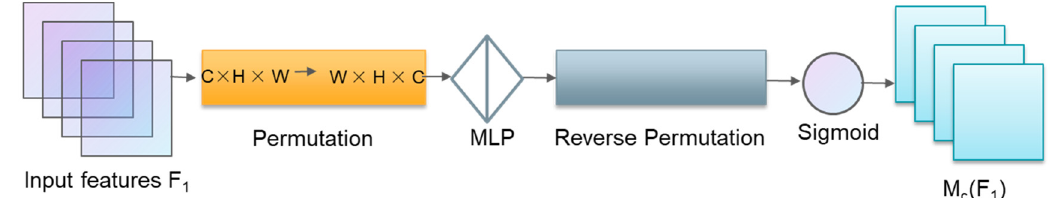
Figure 4. The structure of the channel attention submodule (contains MLP capable of amplifying channel-space dependencies).